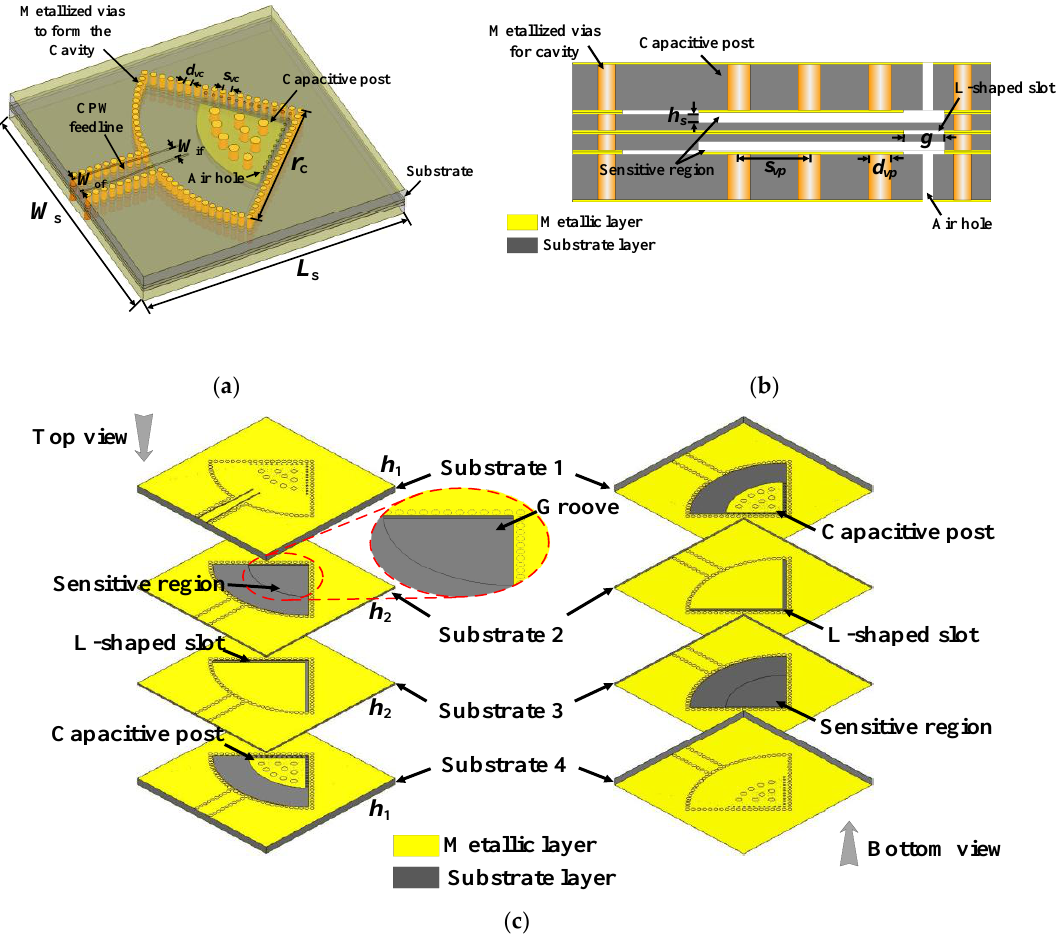
Figure 1. Diagram of the proposed double-folded substrate integrated waveguide (DFSIW) re-entrant cavity: ( a ) full view; ( b ) cutaway view (without feedline); ( c ) exploded view. Table 1. Geometrical parameters of the final optimized cavity.